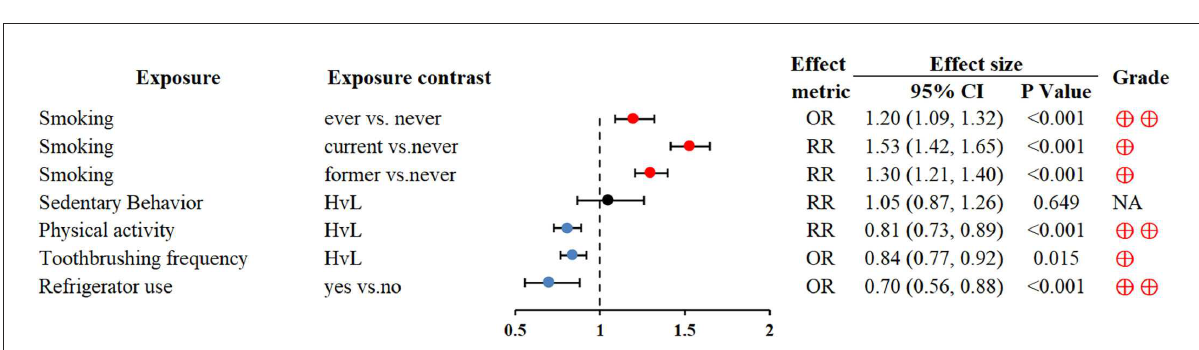
FIGURE6 Forest plot: summary effect estimates of meta-analyses reporting associations between GC and factors pertaining to use of lifestyle.